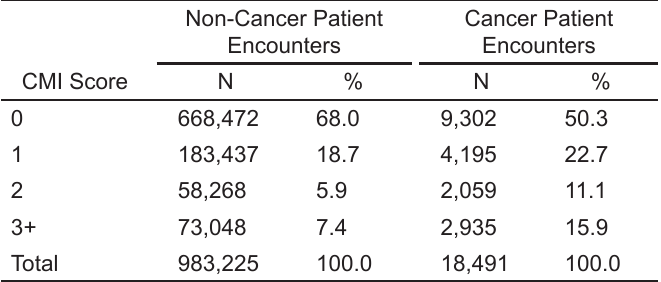
Table 2. Comorbidity index score category associated with